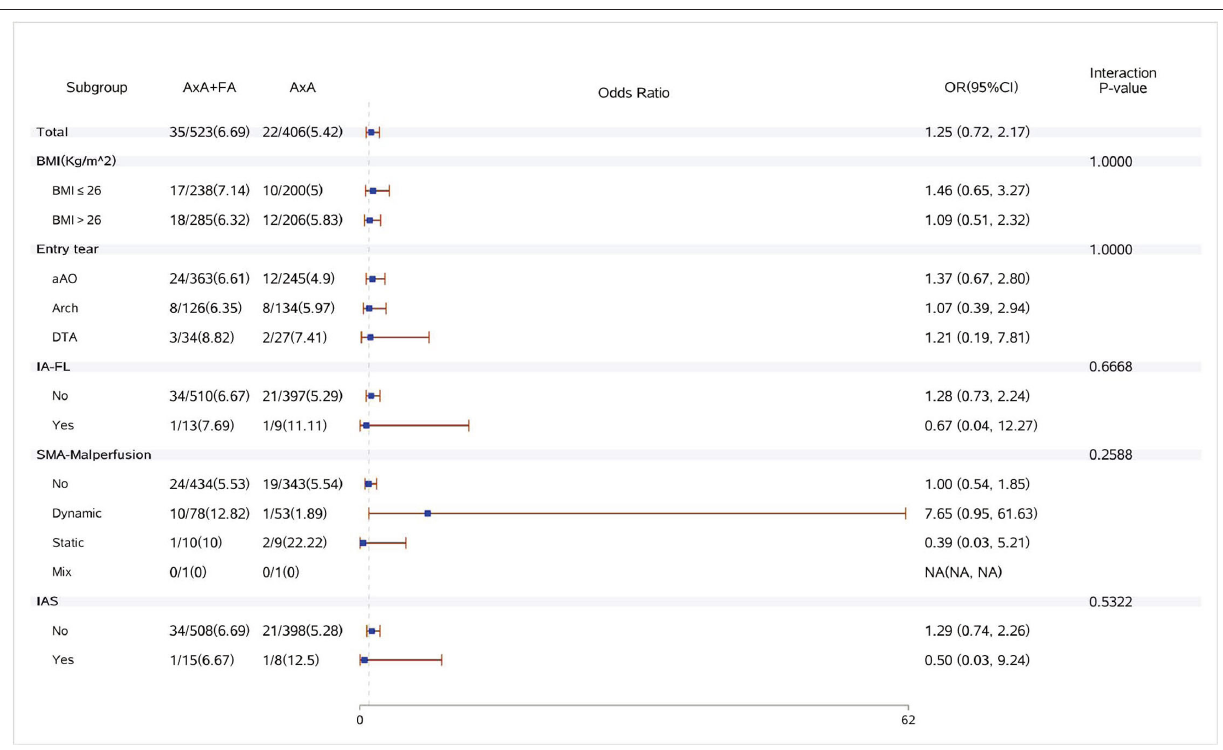
FIGURE 1 | Forest plot of dual arterial cannulation vs. axillary artery cannulation regarding operative mortality by subgroups. AXA + FA, axillary artery cannulation + femoral artery cannulation; AXA, axillary artery cannulation; IA-FL, innominate artery originating from false lumen; SMA, superior mesenteric artery; and IAS, innominate artery